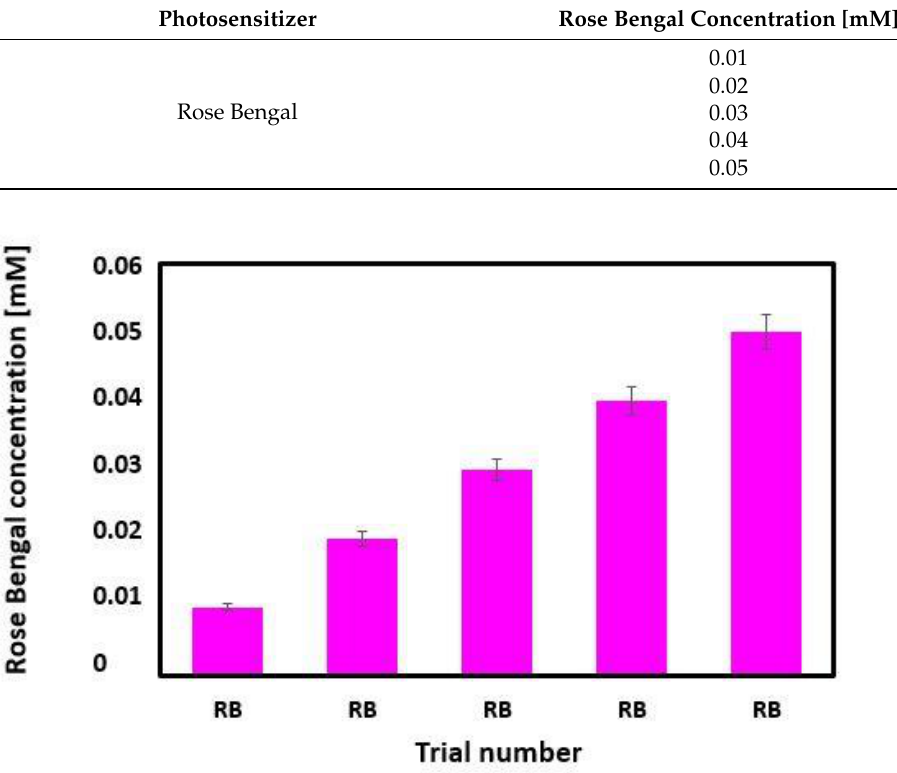
Table 1. Concentration of rose bengal.